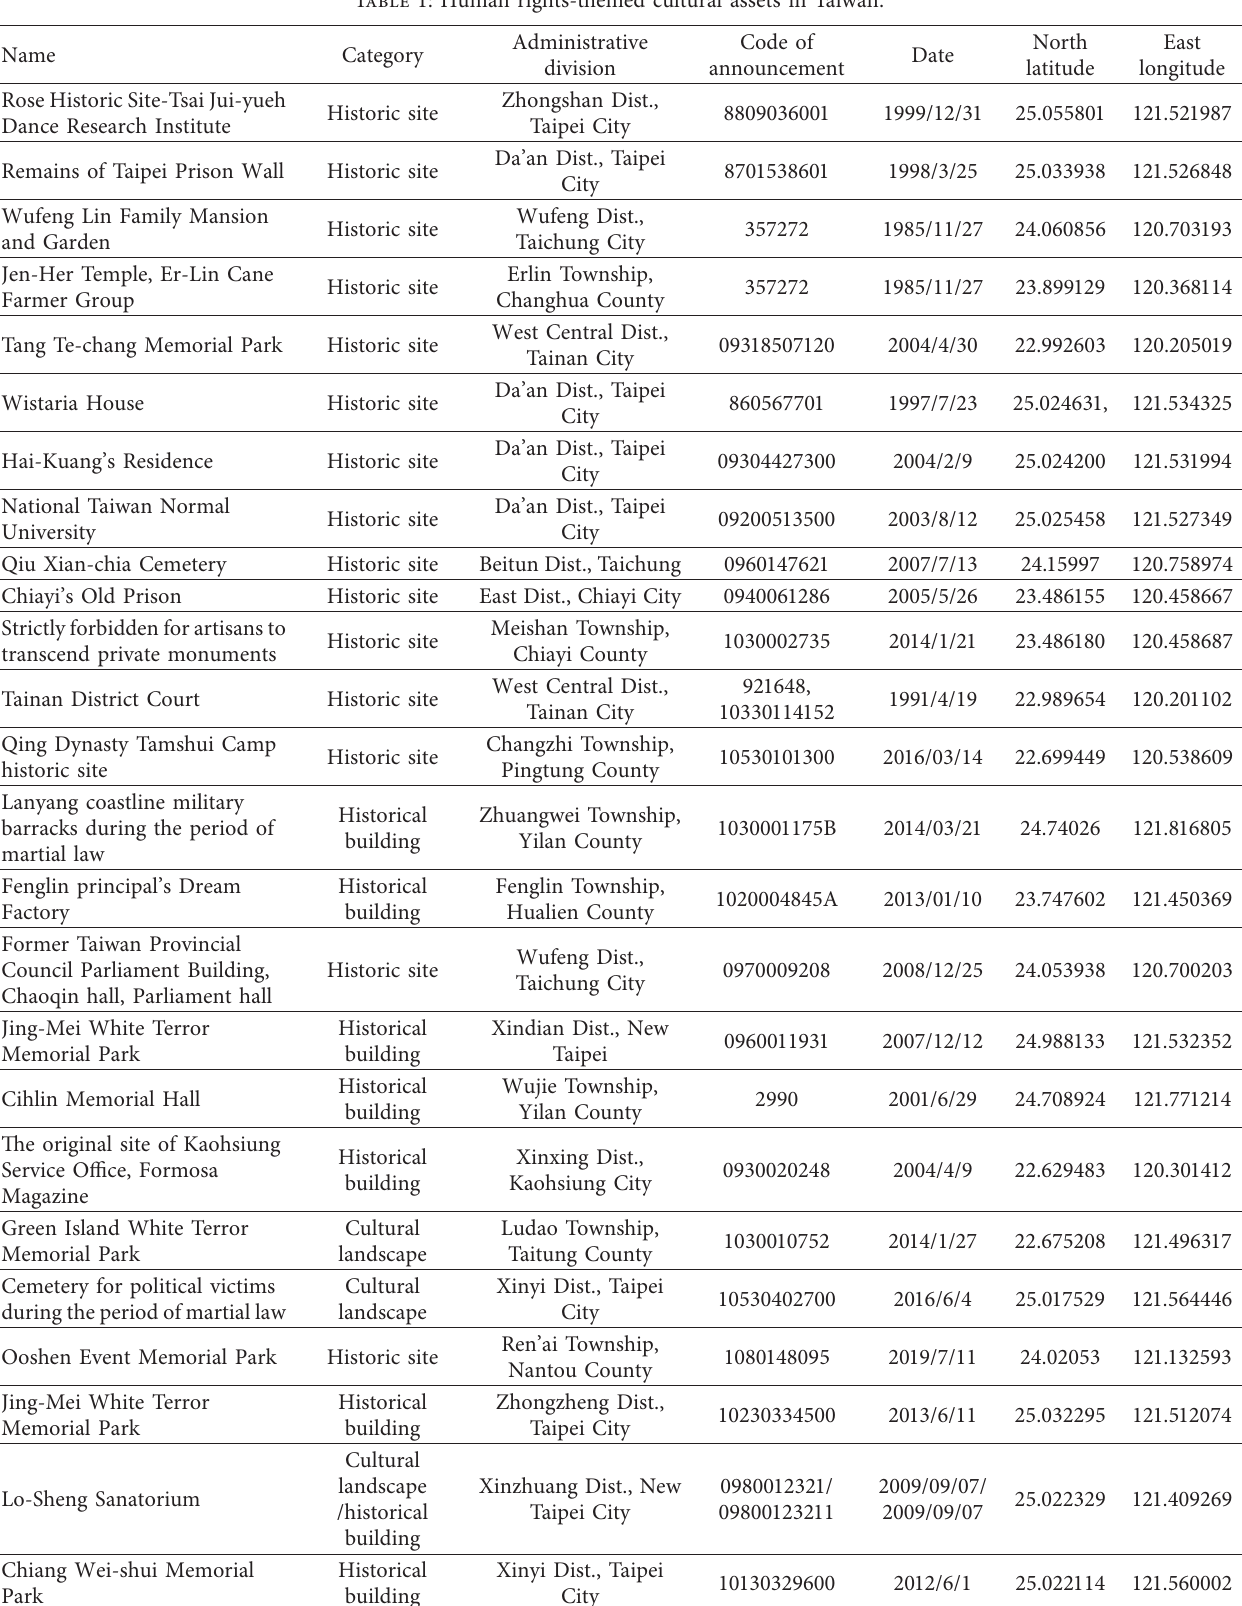
Table 1: Human rights-themed cultural assets in